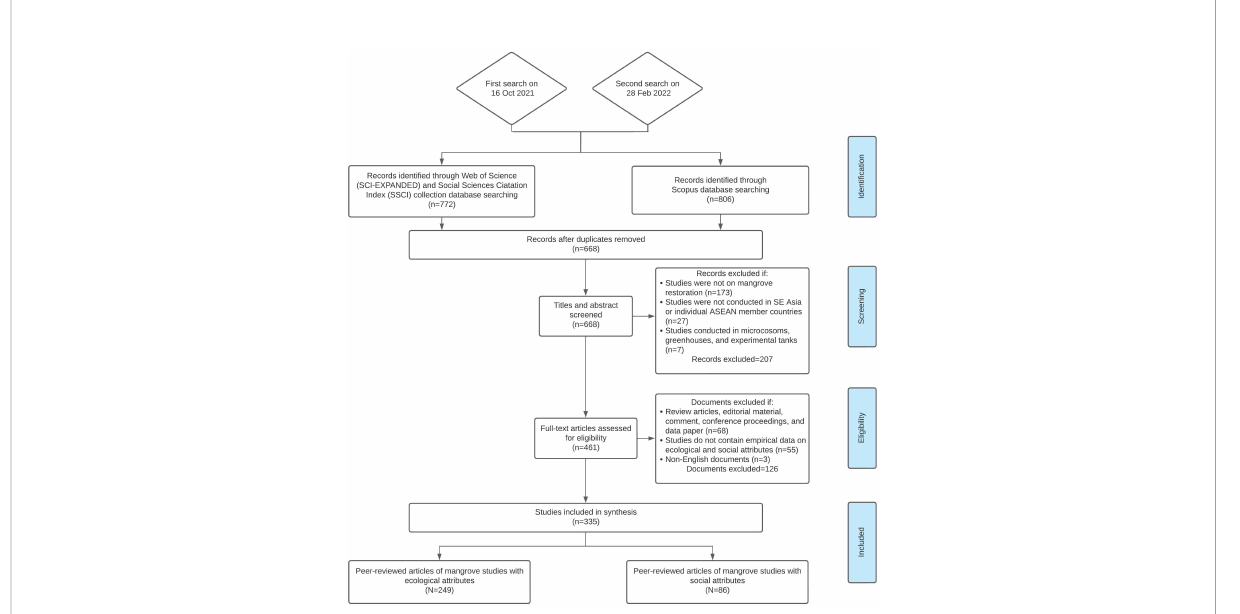
FIGURE 1 PRISMA (Preferred Reporting Items for Systematic Reviews) fl ow diagram of bibliographic analysis in the systematic